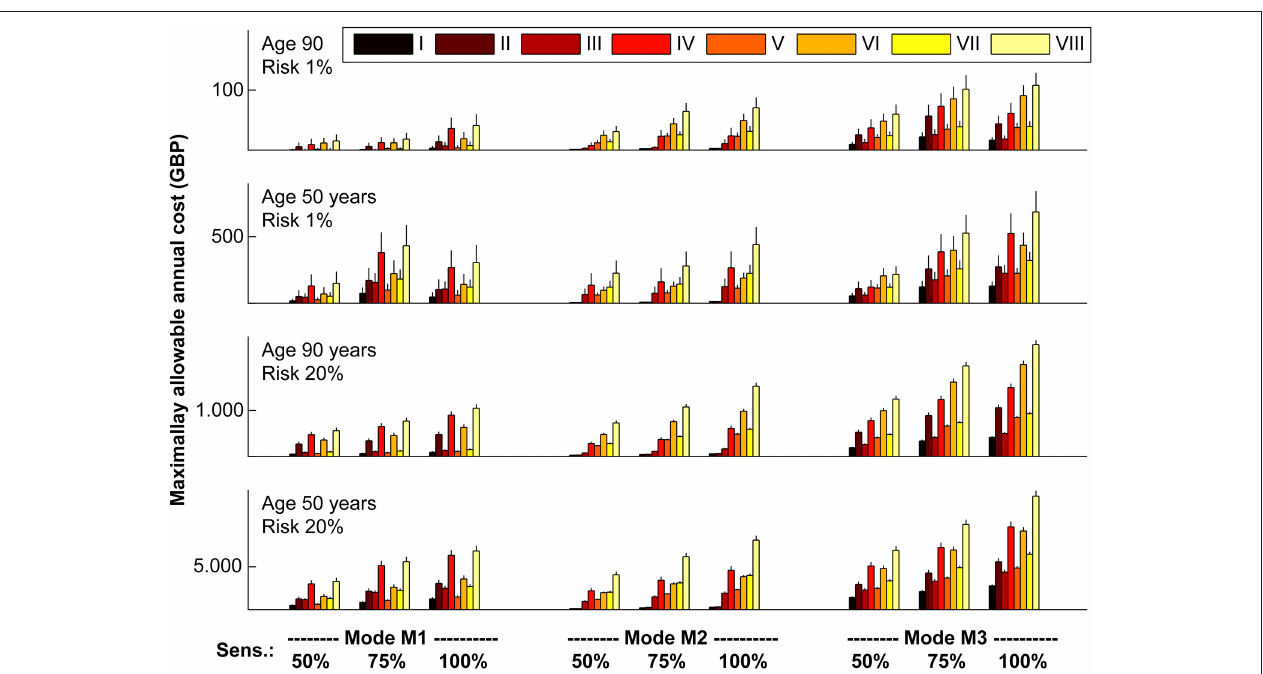
FIGURE 6 | Maximally allowable annual cost of device according to socio-geographic scenario (I–VIII), mode of operation (M1–M3) and sensitivity (50, 75, and 100%) for acute ischaemic stroke detection in four demographically distinct sub-populations. Vertical lines represent standard errors of the mean. For a definition of socio-geographic scenarios and modes of operation of the device, see main text and Tables 4 , 7 . Note the different scaling of the vertical